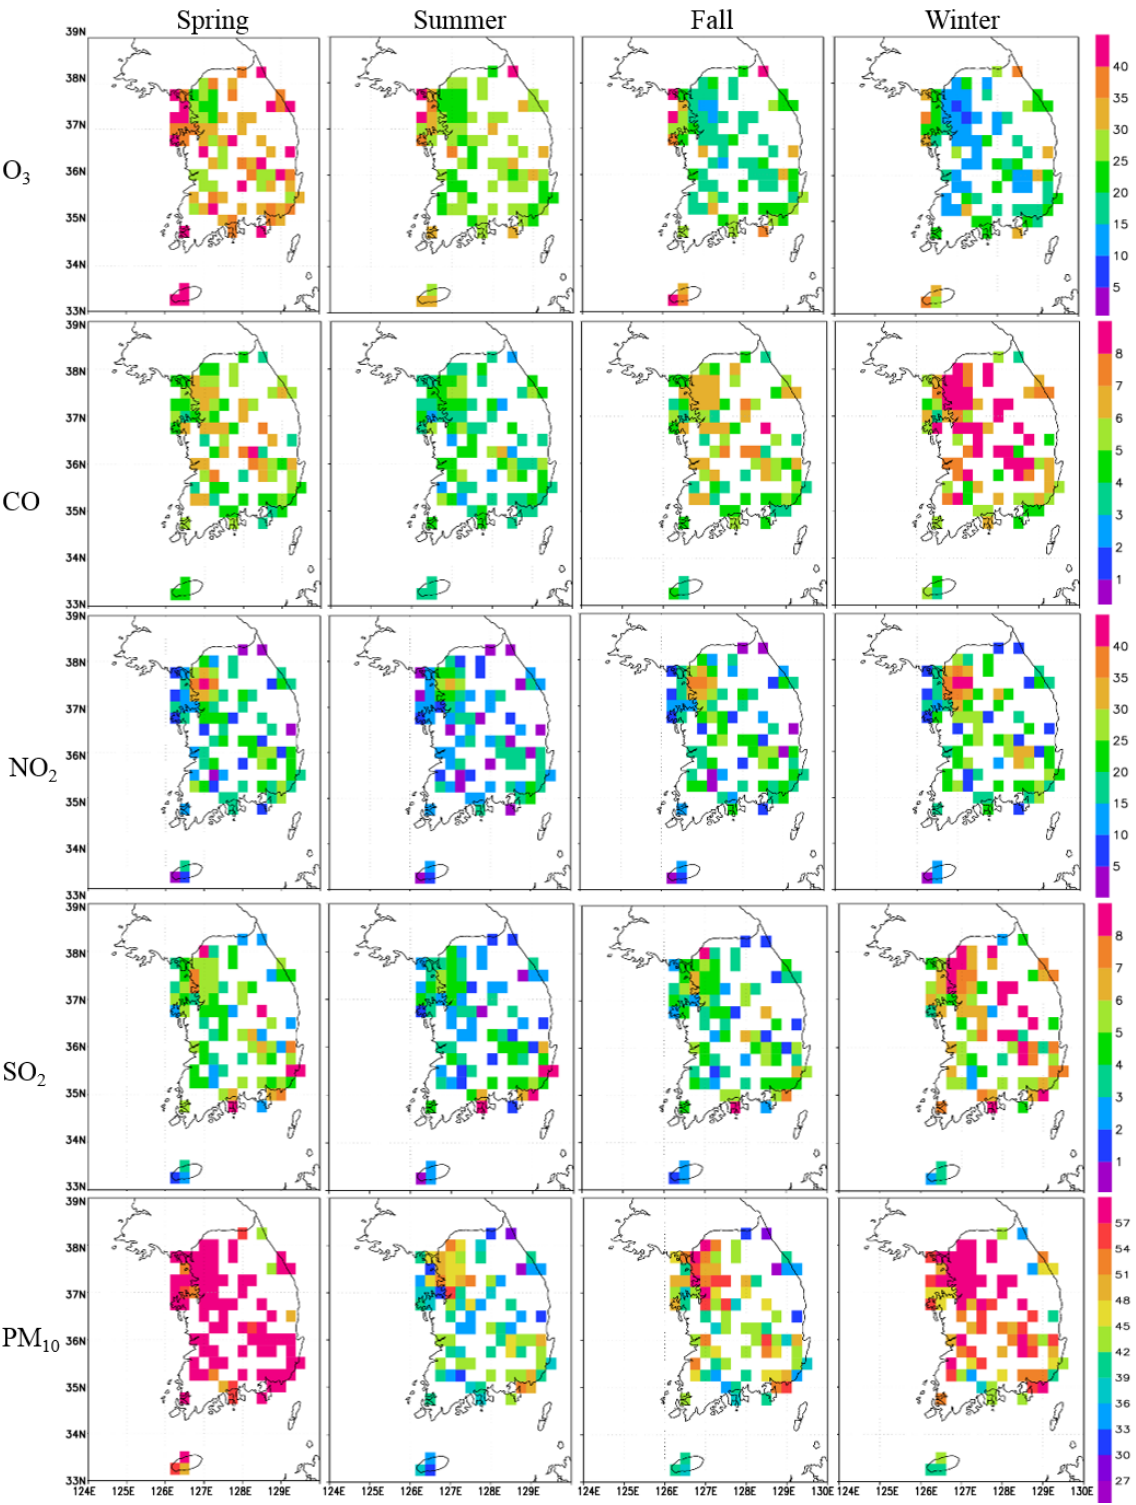
Figure 4. Climatological seasonal averages of O 3 (ppb), CO (0.1ppm), SO 2 (ppb), NO 2 (ppb), and PM 10 (µgm − 3 ) in a 0.25 ◦ × 0.25 ◦ grid over South Korea during